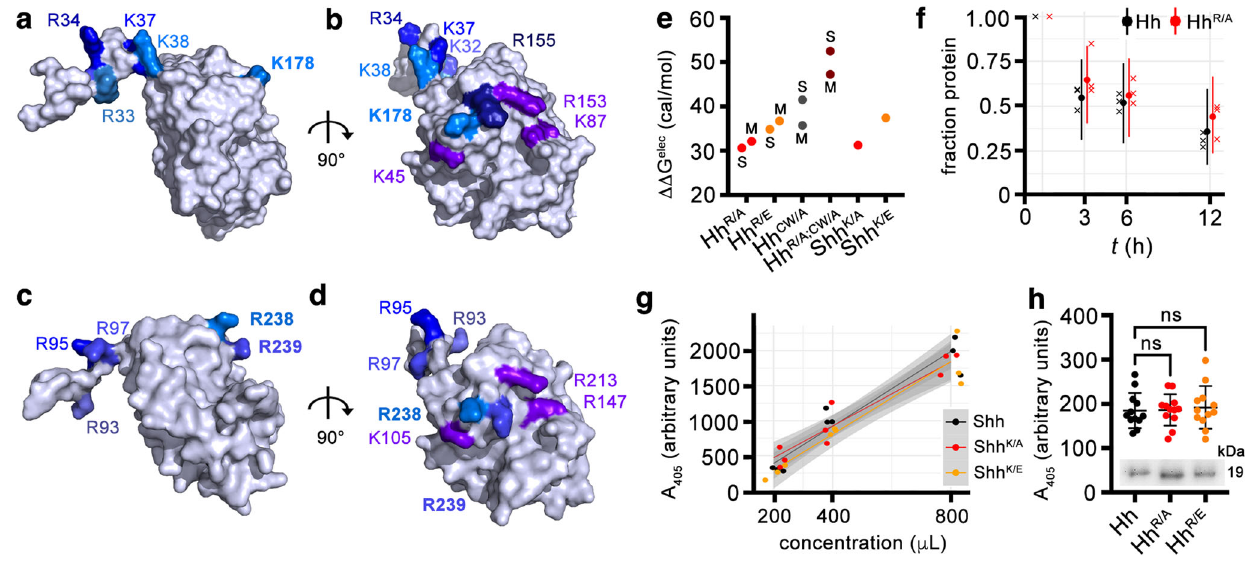
Fig. 1 | Two HS-binding sites in Shh and modeled Drosophila melanogaster Hh. a – d The fi rstestablishedHS-bindingsite(theCardin-Weintraub(CW)motif)ofShh ( a , b , pdb: 3m1n) or of D. melanogaster Hh ( c , d ) is located at the N-terminal extension of one monomer (left in a , c and top in b , d ), whereas the second site comprises residues on the globular domain. HS-binding basic residues are in dif- ferentshadesofblueandresiduesthatalsobindtoPtcreceptorsareinviolet.Both HS-binding sites are far from each other in the monomeric structures, with a median distance of ~2.7nm. See Supplementary Tables 1, 2 for details. e In silico analysisoftheeffectofmutationsinwild-type Drosophila HhN Δ 251 – 257andhuman ShhN Δ 191 – 197 on the electrostatic contribution to the binding af fi nity against a heparin disaccharide. ΔΔ G elec values express the difference of Δ G elec between each mutant protein and its corresponding wild-type protein. In Hh, both the CW domain and globular domain contribute to heparin binding. In both Shh and Hh, the globular glutamate variants have a lower af fi nity to heparin than the alanine variants. Annotations M and S distinguish results based on different template structures of protein (Electrostatic calculations in Methods, Source data are pro- videdasaSource Data fi le). f Remaining fractionof Hh(black)and Hh R/A (red)after 0, 3, 6, and 12h. Crosses correspond to measured data with small shifts along the